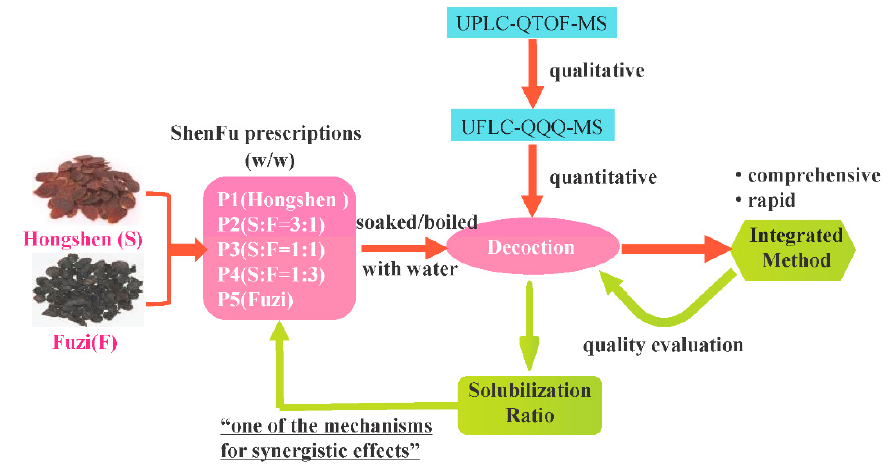
Figure 1. The flow chart illustrates the overall strategy for